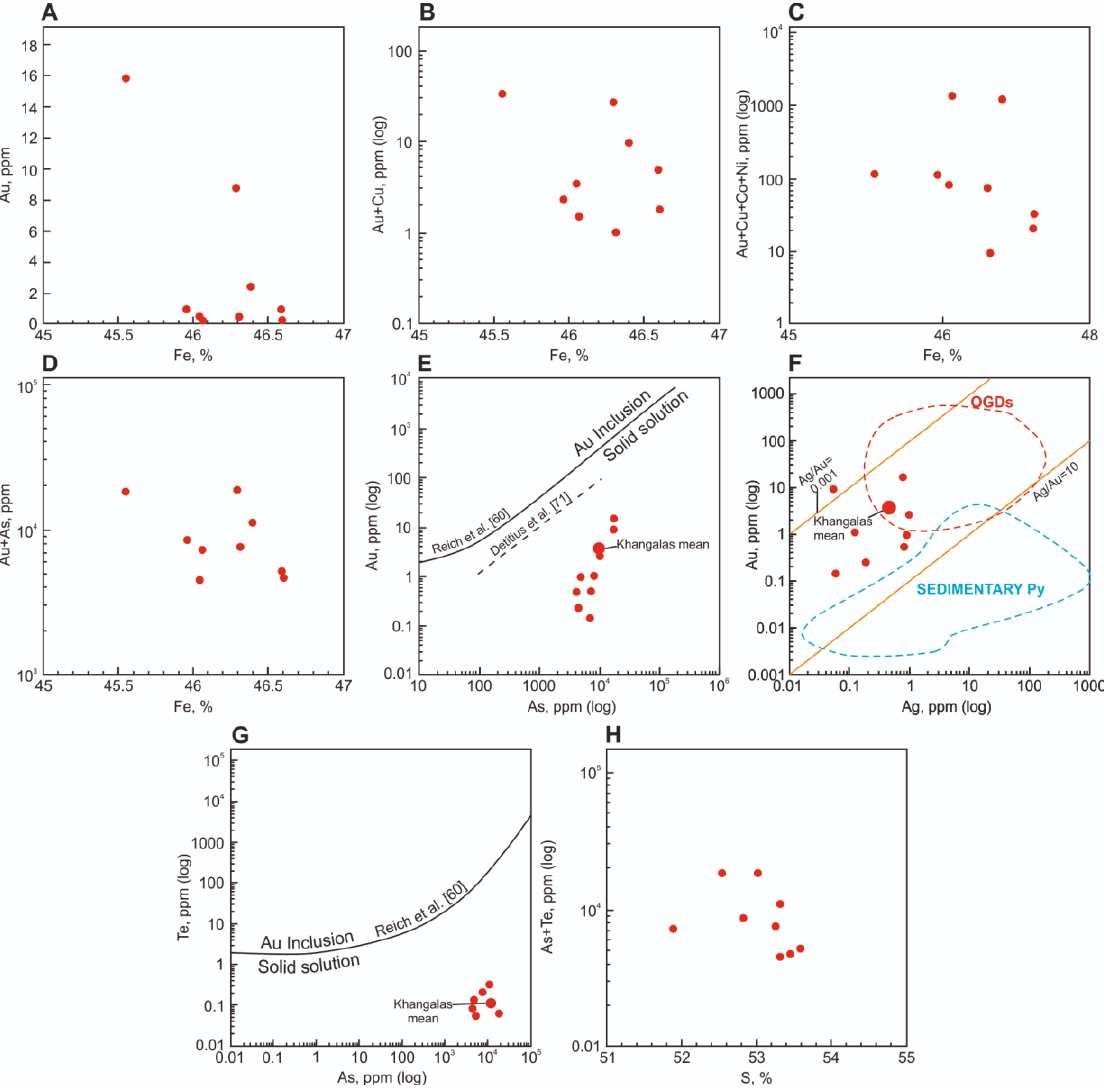
12 Figure 12. Binary correlation diagrams for Ру 3: ( A ) Fe vs. Au; ( B ) Fe vs. Au + Cu; ( C ) Fe vs. Au + Cu + Co + Ni; ( D ) Fe vs. Au + As; ( E ) As vs. Au; ( F ) Ag vs. Au, field of orogenic gold deposits (OGDs) and sedimentary Py after Large and Maslennikov [68]; ( G ) As vs. Te; ( H ) S vs. Te +